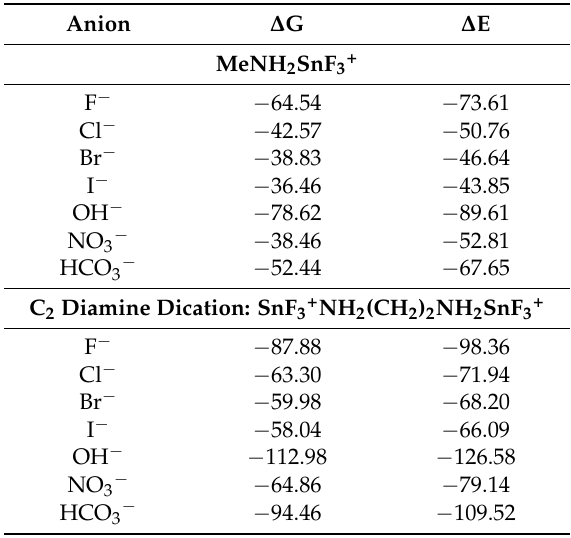
3+ cations. Distances in Å. 3 NH 2 SnF